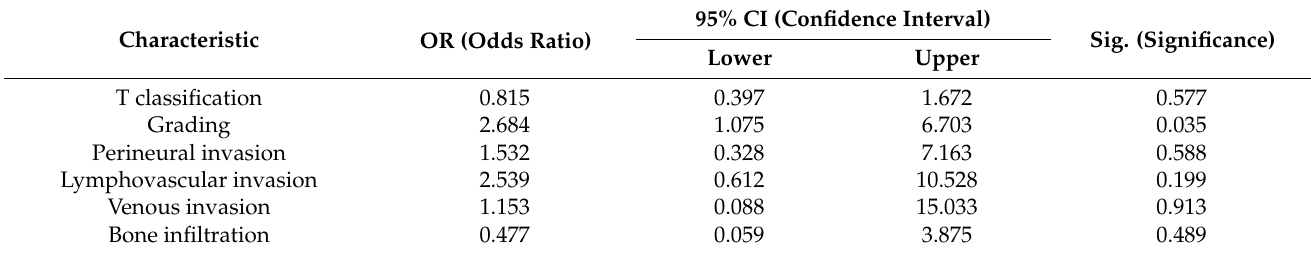
Table 2. Results of the logistic regression